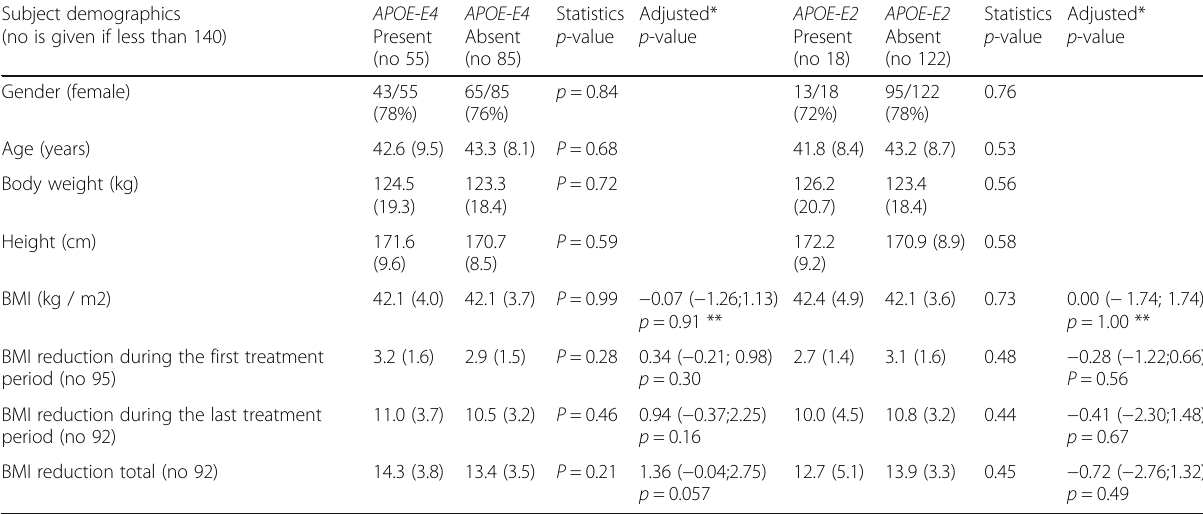
Table 1 Associations between the subjects ’ demographics and APOE E4 and E2 variants Subject demographics (no is given if less than